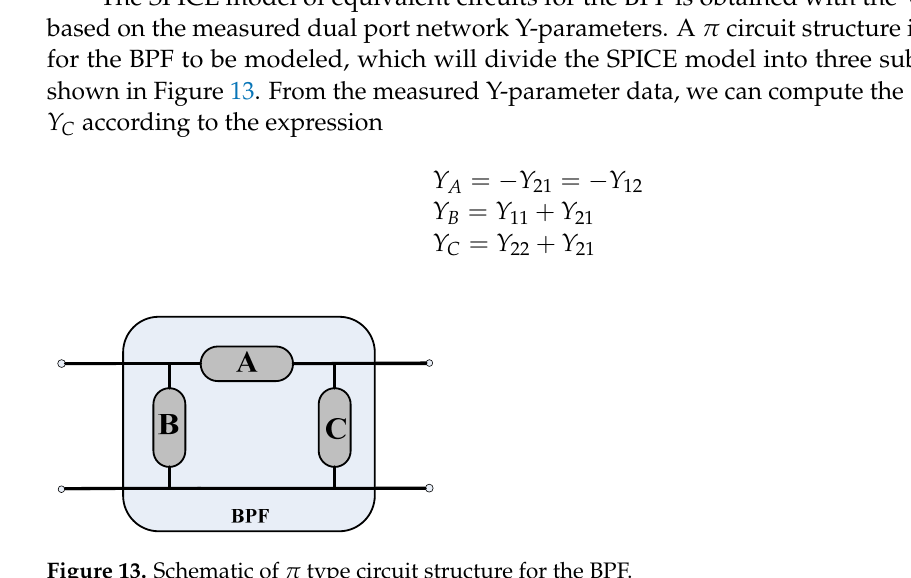
Figure 13. Schematic of π type circuit structure for the BPF.